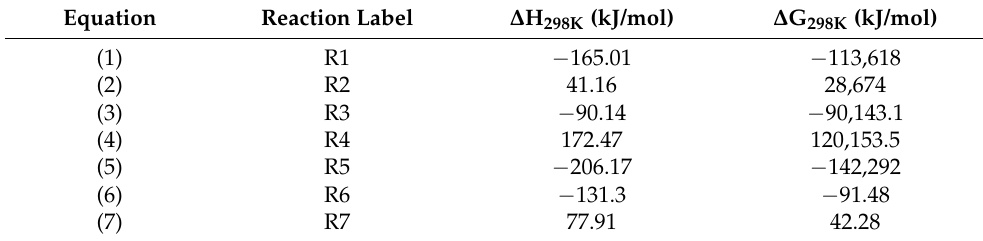
Table 1. List of CO 2 methanation and possible side